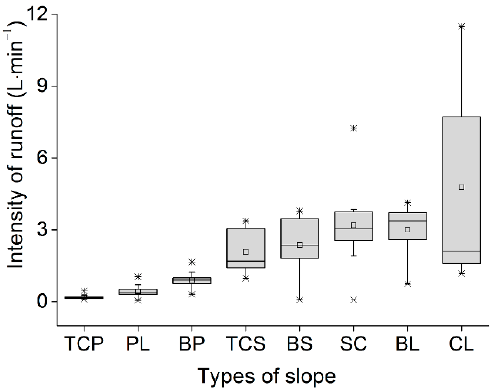
Figure 7. Average intensity of runoff with different slope treatments.